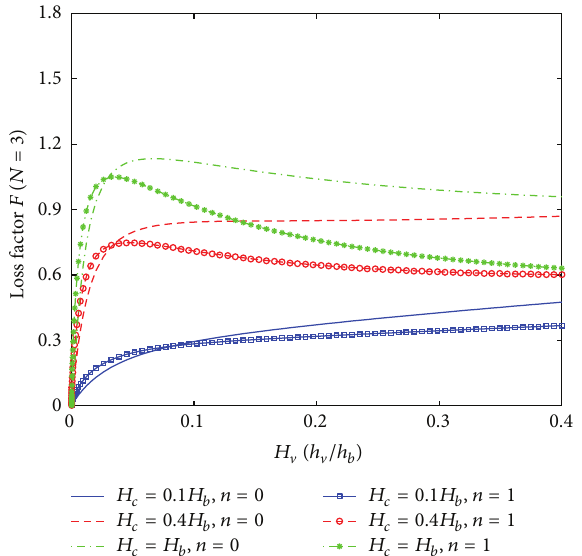
Figure 12: Efficiency curves for full-cover and segmented CLD beams with various values of 𝐻 𝑐 ( 𝐻 𝑏 = 0.012 ).